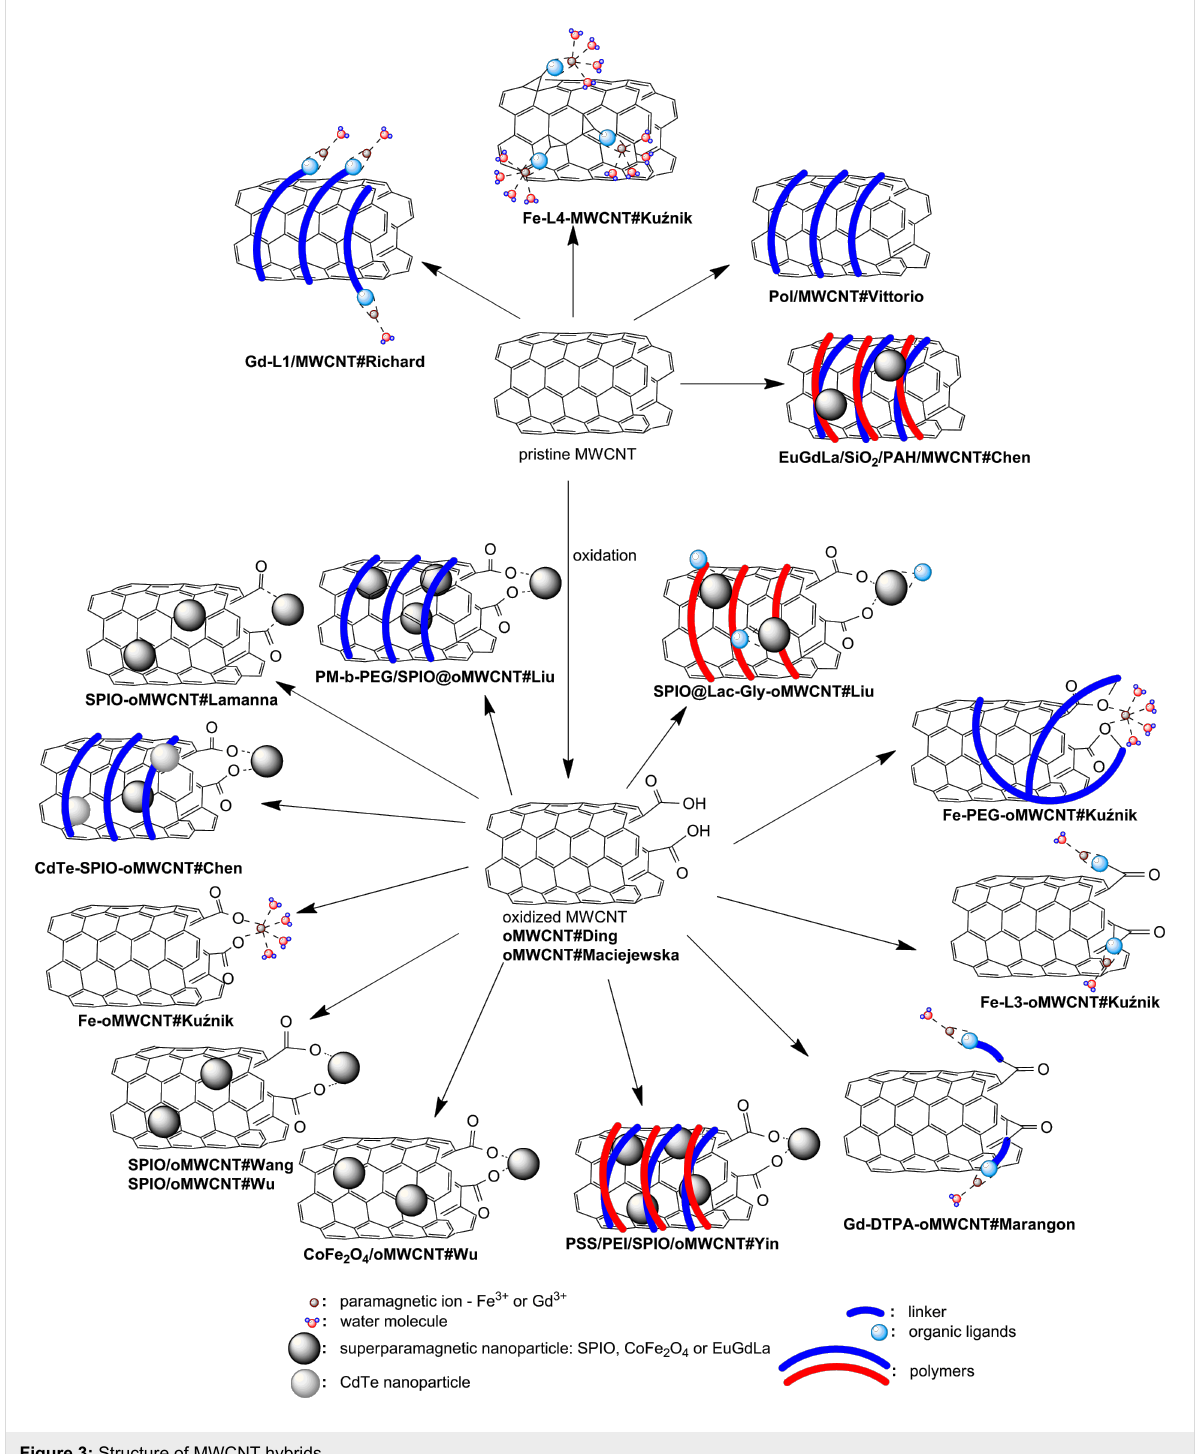
Figure 3: Structure of MWCNT hybrids.